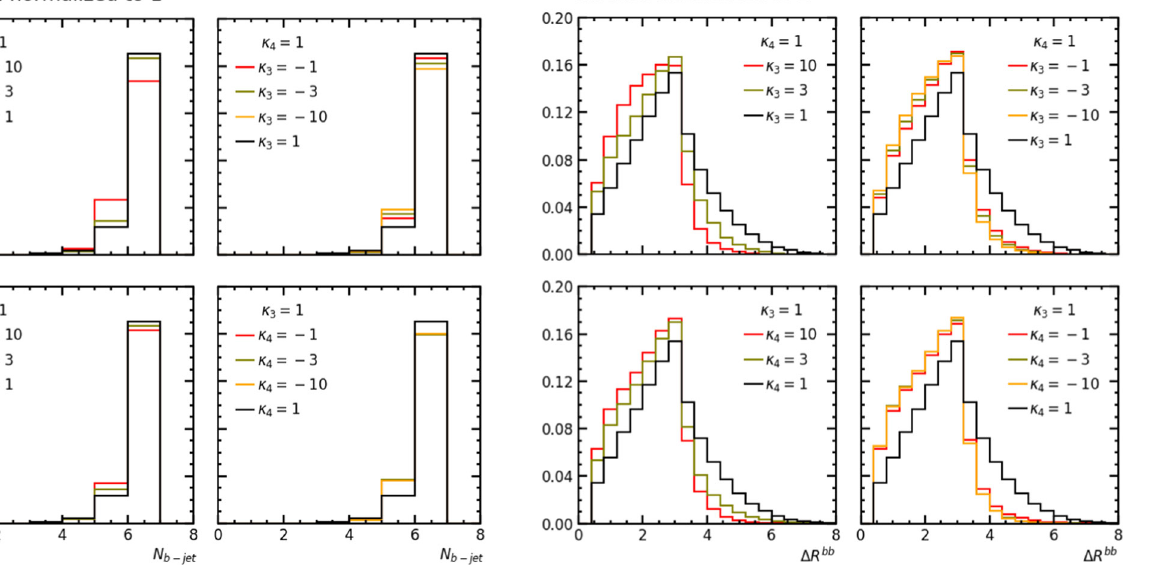
Fig. 32 Distribution of e + e − → b ¯ bb ¯ bb ¯ b ν ¯ ν events with respect to the number of b -jets, for several values of the parameters κ 3 and κ 4 . Note that the number of b -jets is not necessarily six due to the resolution criterion